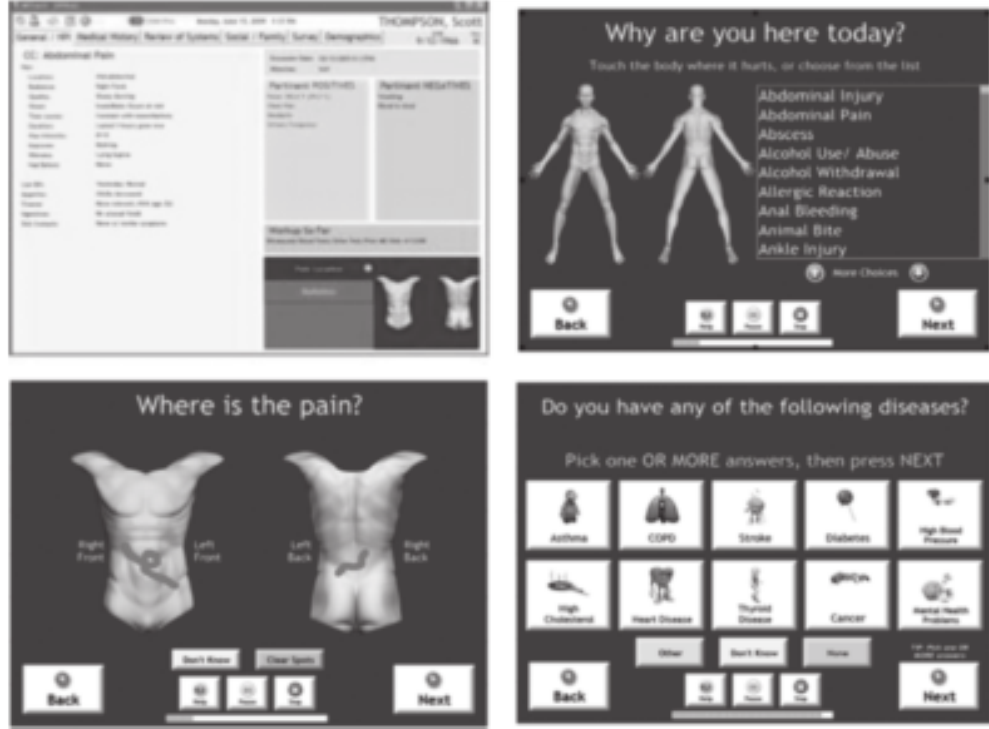
Figure . Screenshot of PatientTouch e , a handheld self-administered history-taking